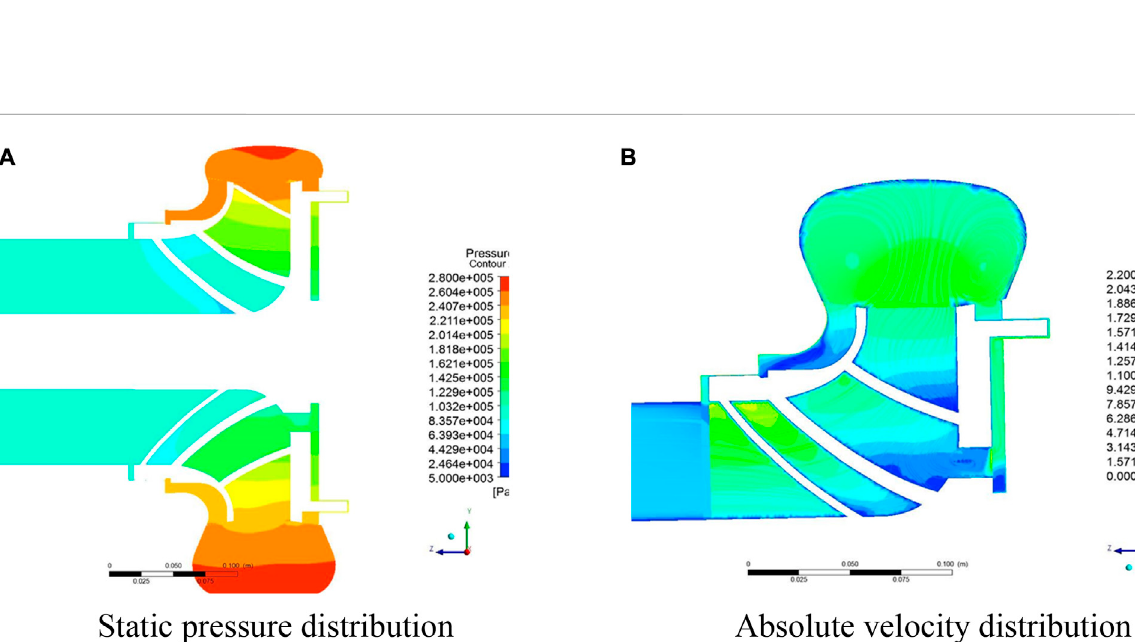
In addition, the strength of the double volute chamber is better than that of the single volute chamber, and the radial force is effectively reduced by more than 30%.